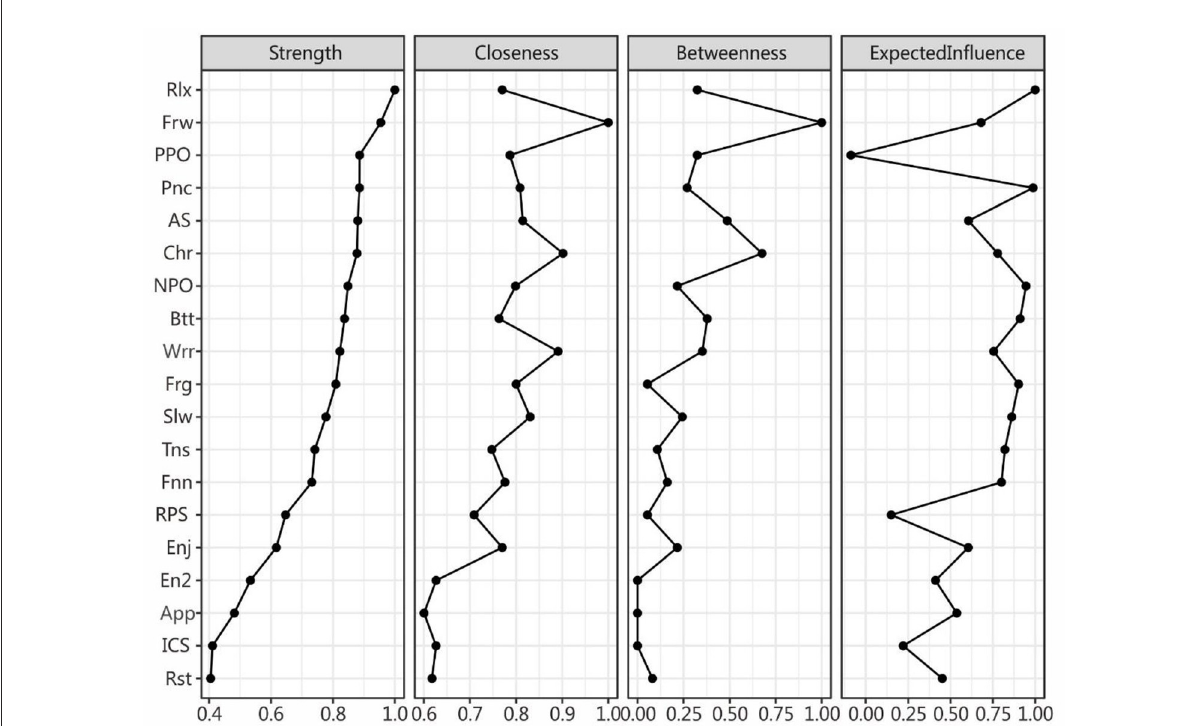
FIGURE2 Centrality indices for the nodes of the present network including those for strength betweenness closeness expected influence. The values are normalized to be within the range of 0–1. The full names of the abbreviations can be found in Figure